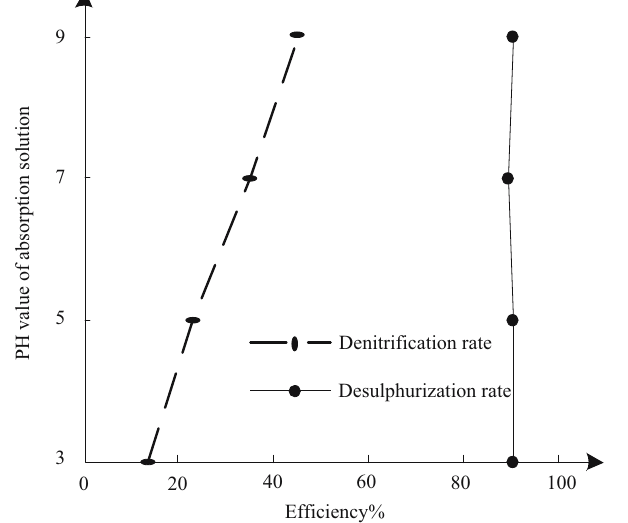
Figure 3: E ff ect of pH value of absorption solution on desulfurization and denitri fi cation of sintering fl ue gas.